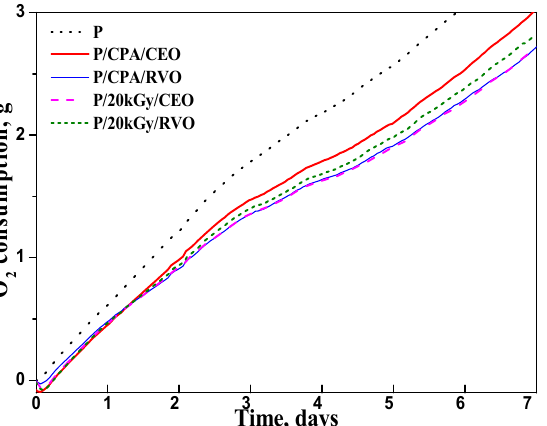
Figure 7. Time evolution of oxygen consumption during curd cheese storage in contact with kraft paper loaded with plant oils.